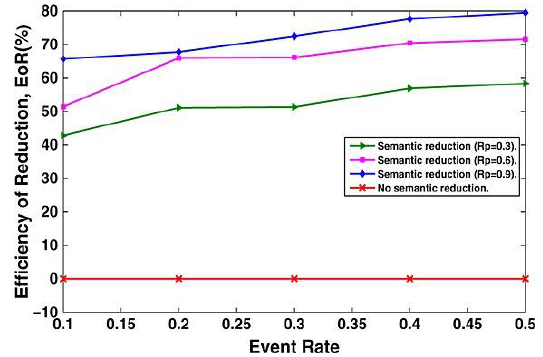
Fig.16. Impact of event rate on efficiency of